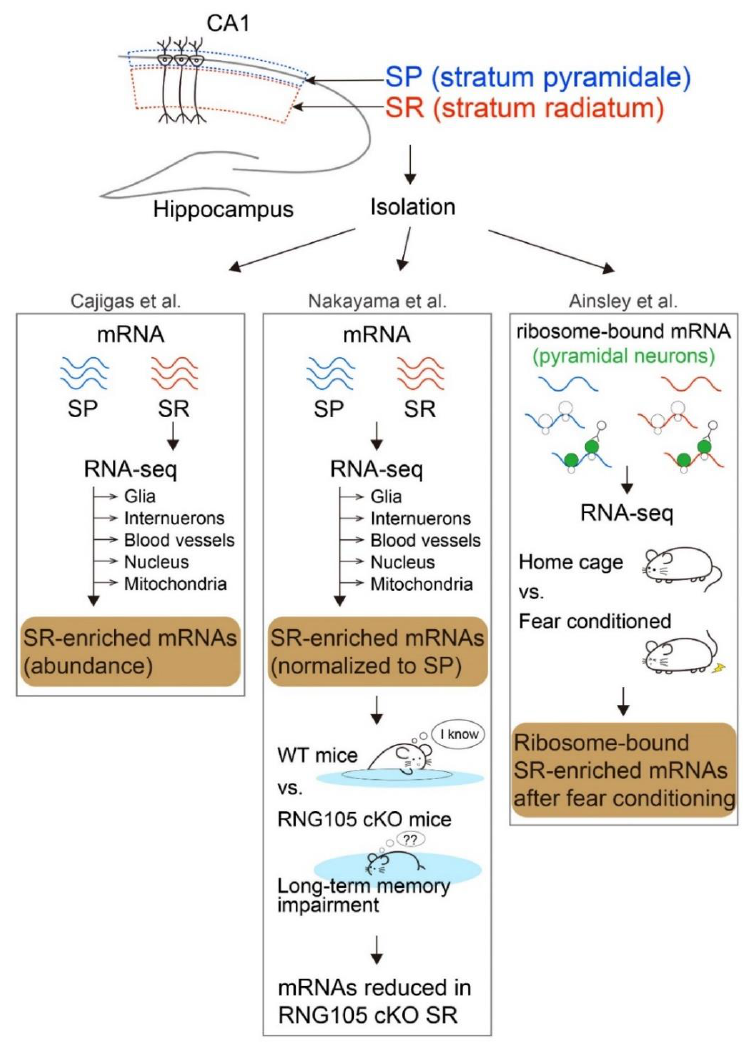
Figure 1. Identification of mRNAs localized to the dendrite-enriched stratum radiatum (SR) layer